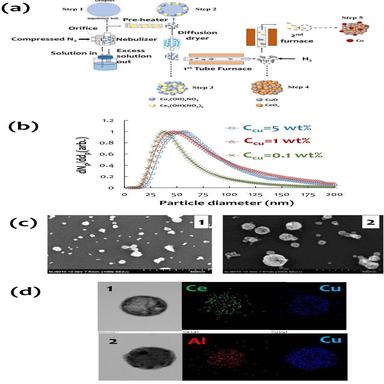
Aerosol-based synthesis of functional nanoparticle powder using an aerosol spray method. (a) Schematic diagram of the aerosol spray method. (b) Differential mobility analysis of bare CuO NPs with different precursor concentrations of Cu (CCu). (c) Representative SEM images of bare CuO NP. 1: CCu = 0.1 wt%. 2: CCu = 5 wt %. (d) HRTEM images with elemental mapping of the CuOx-based hybrid NPs. 1: CuO-CeO2 hybrid NP; 2: CuO-Al2O3 hybrid NP. (a) Reprinted with permission from Ref. . (b–d) Reprinted